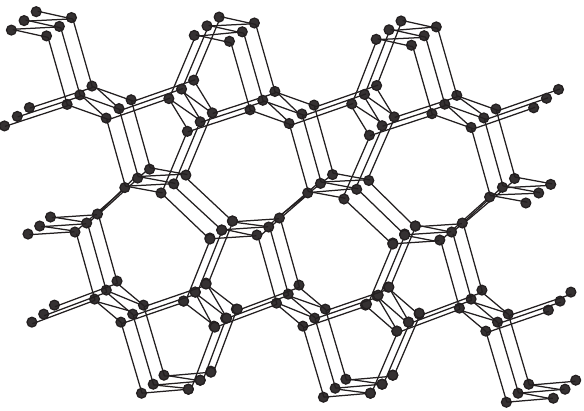
Figure 1: The M-carbon structure M Table 1: Famous degree-based topological indices.